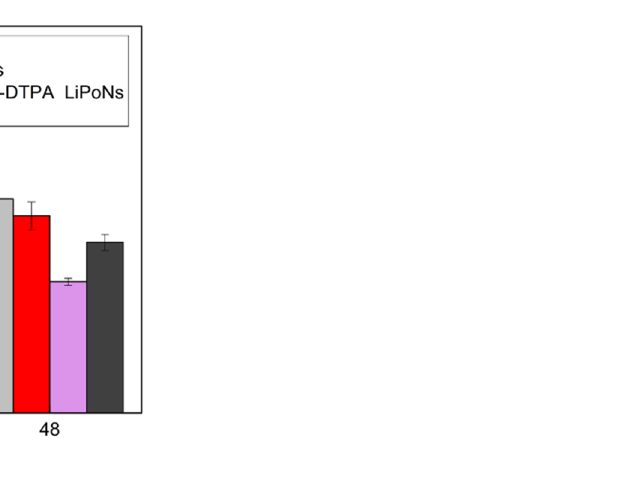
Figure 8. Viability of U87 MG cells treated with theranostic LiPoNs. Comparison of cell viability % of U87 MG cells treated for 24 h and 48 h with 7.7 μ M of free irinotecan and in IRI ‐ Gd ‐ DTPA co ‐ loaded LiPoNs formulation (lipid conc.: 0.4 mg/mL, Gd ‐ DTPA conc.: 1.25 mM). The cell viability % of U87 MG cells in the presence of blank LiPoNs at the same tested conditions of IRI ‐ Gd ‐ DTPA LipoNs is reported.